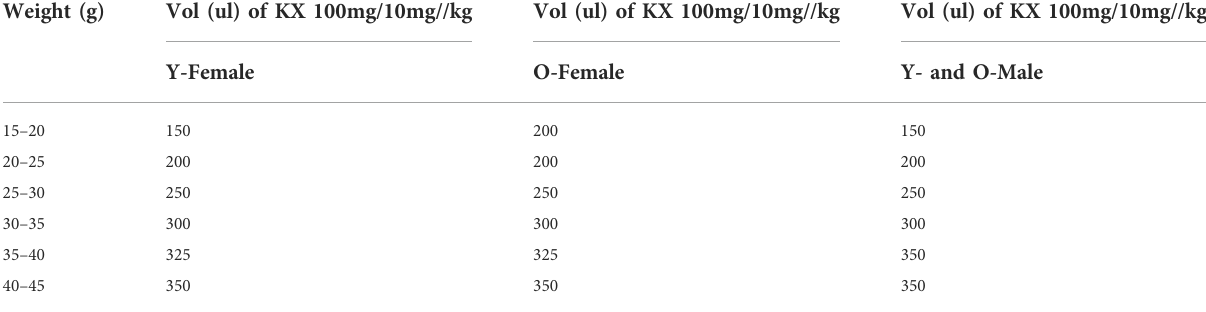
TABLE 1 Combination ketamine and xylazine (KX) anesthesia dosing recommendations for young and old C57BL6 mice prior to parabiosis surgery. Weight